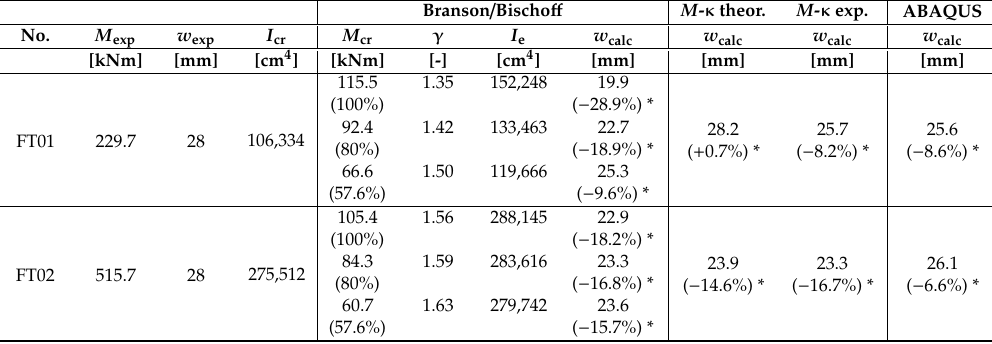
Table 6. Prediction of deflection with Equation (3), with M - κ -relation and with FE-model.